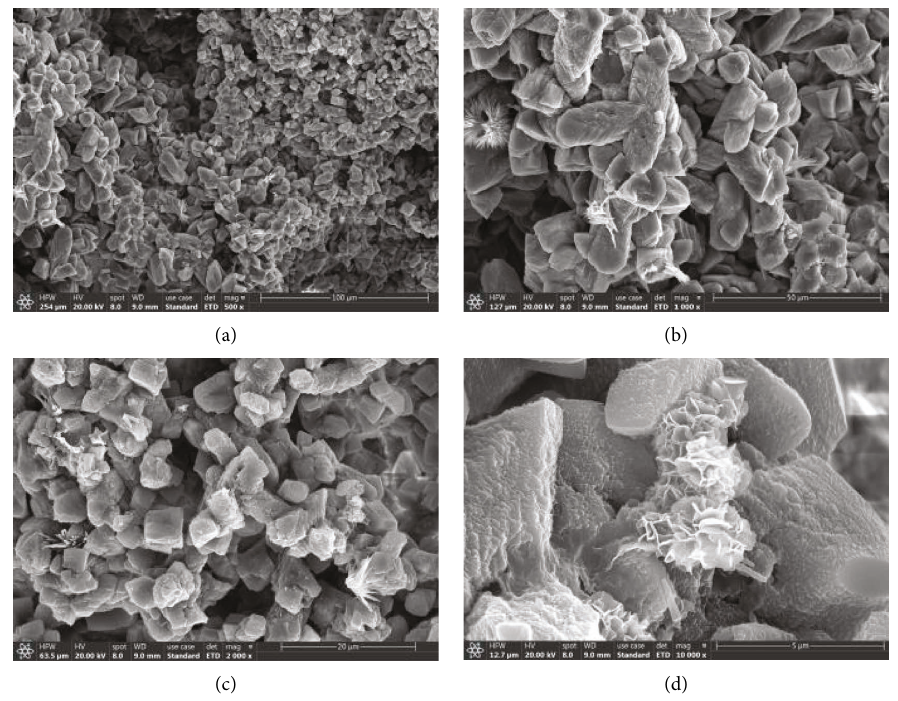
Figure 2: Microscopic view of crystals. (a) 500 times SEM of crystal. (b) 1000 times SEM of crystal. (c) 2000 times SEM of crystal. (d) 10000 times SEM of